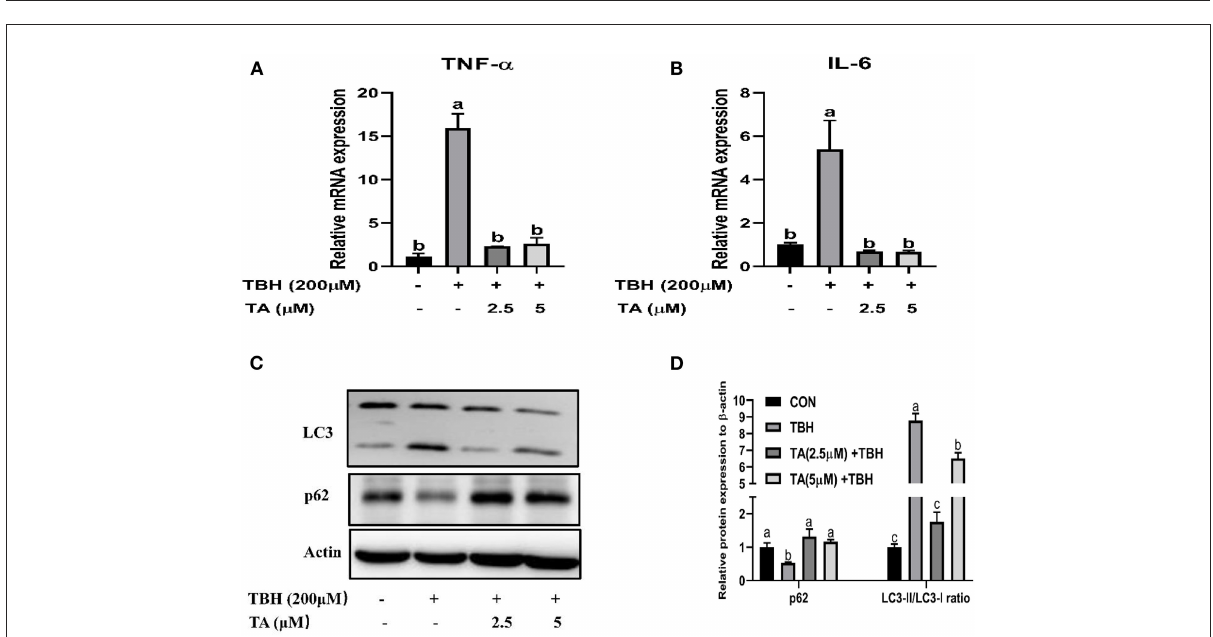
FIGURE8 Effects of tannic acid (TA) on the inflammatory cytokines and autophagy of IPEC-J2 cells. The mRNA expression of TNF- α (A) and IL-6 (B) . Western blotting analysis of the protein expression of LC3 and p62 is shown (C) . Quantitative analysis of the protein expression of LC3 and p62 (D) . Data are presented as mean ± SEM, n = 3. TA, tannic acid; TBH, tert-butyl hydroperoxide. a,b values in the same row not sharing a common superscript differ